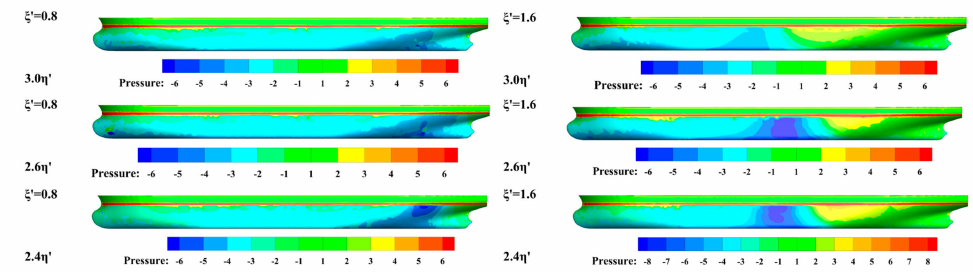
Figure 19. The dynamic pressure distribution of DS’s side surface at different lateral